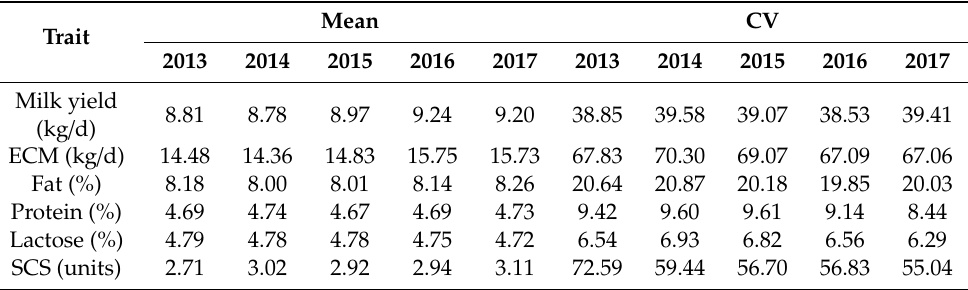
Table 1. Mean and coe ffi cient of variation (CV, %) of bu ff alo milk yield, energy corrected milk (ECM), composition traits, and somatic cell score (SCS) per year of sampling ( n = 980,330) Mean Trait